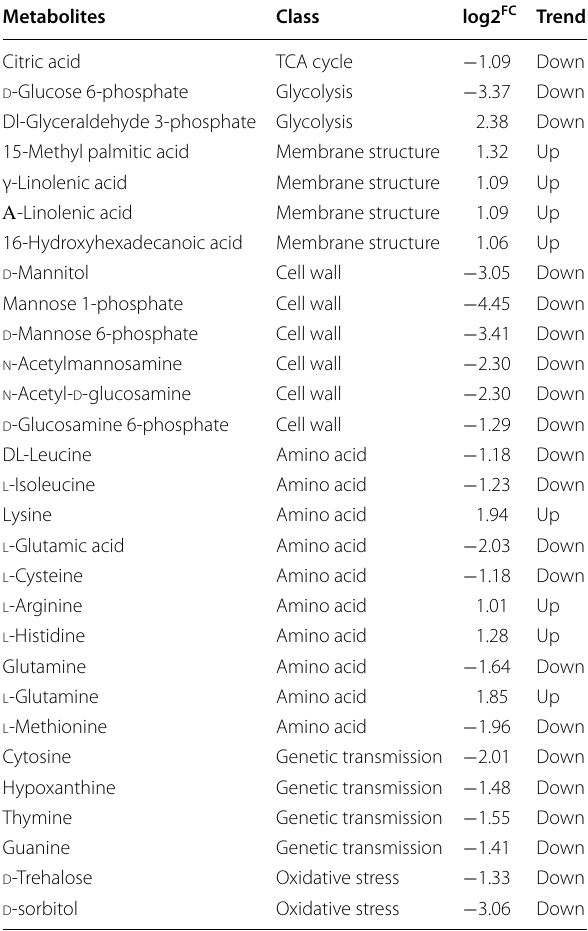
Table 3 Metabolites with statistical differences between X33 AMP-treated and untreated